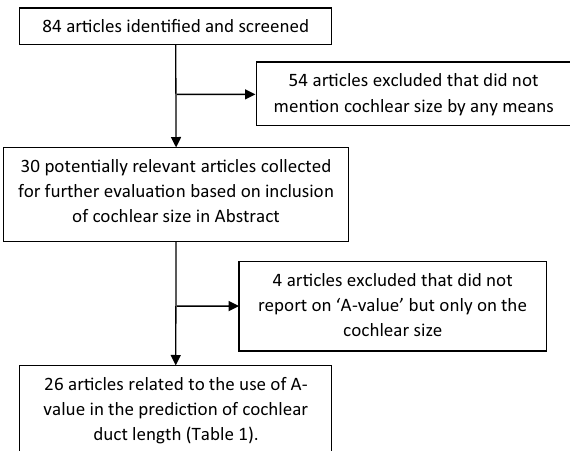
Figure 1. Identification of studies reporting on the A-value of